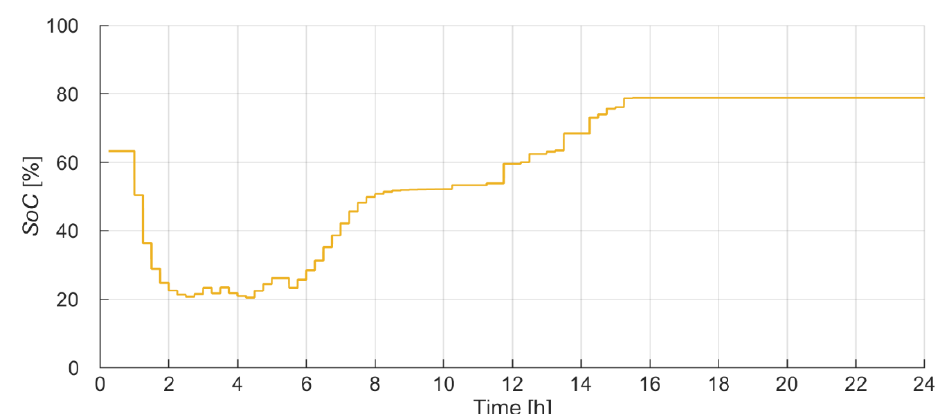
Figure 15. Daily state of charge of the energy storage unit ES_530 (installed in node 530); profile A.